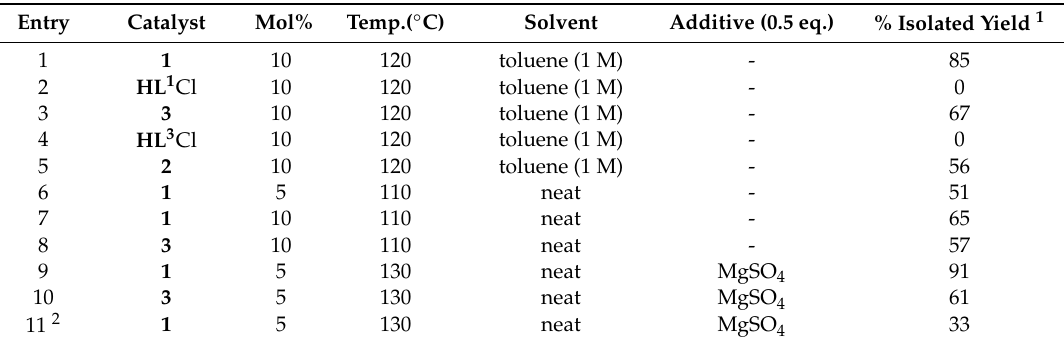
Table 2. Optimization of the reaction